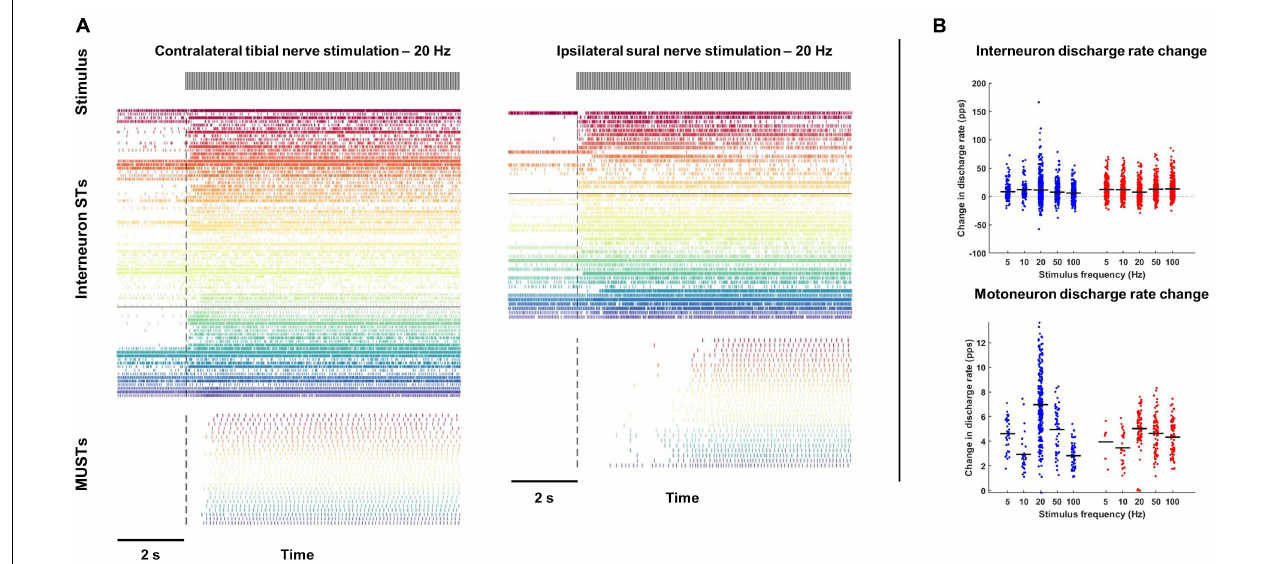
FIGURE 2 | Changes in interneuron and motoneuron spike times during tibial and sural nerve stimulation. (A) Population spike times of interneuron and motoneuron single units during exemplar trials of tibial (left) and sural (right) nerve stimulation at 20 Hz. (B) With both tibial and sural nerve stimulation, interneurons and motor units changed their discharge rate to a similar degree regardless of stimulation frequency. Motor units were almost exclusively quiescent during the pre-stimulation period and increased their discharge shortly after the onset of stimulation. Most interneurons had some baseline activity and displayed a more heterogeneous response to peripheral nerve